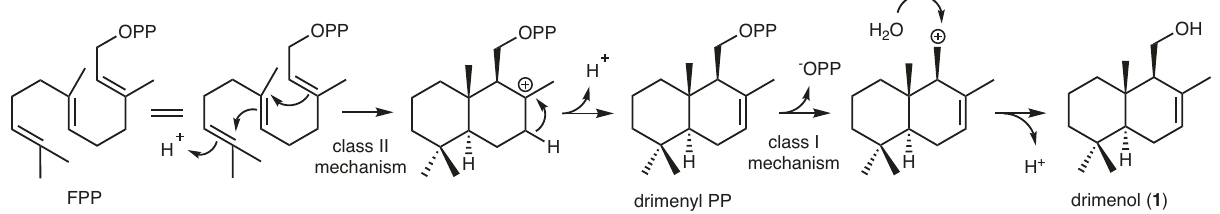
Fig. 5 Putative biosynthesis of drimenol in Termitomyces from FPP via drimenyl PP. The reaction requires enzymatic protonation at C3 via a class II terpene synthase mechanism, followed by dephosphorylation of drimenyl PP by a class I terpene synthase reaction